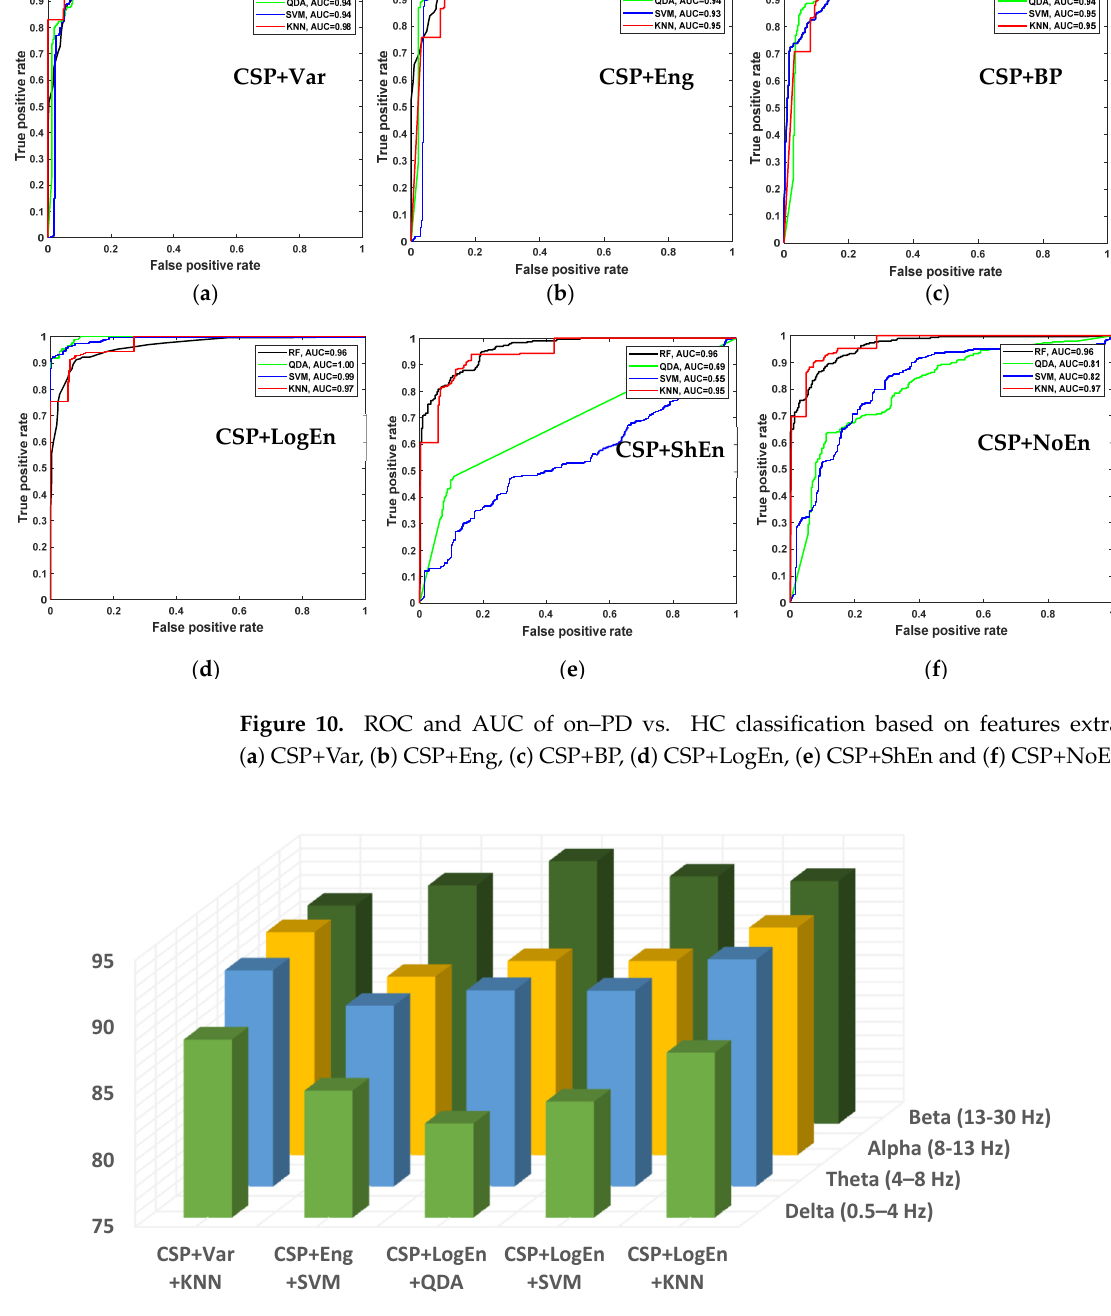
Figure 11. Classification accuracy of different EEG frequency bands using KNN of on–PD vs. HC. Table 10. The effect of frequency bands on classification accuracy using KNN (on–PD vs. HC).